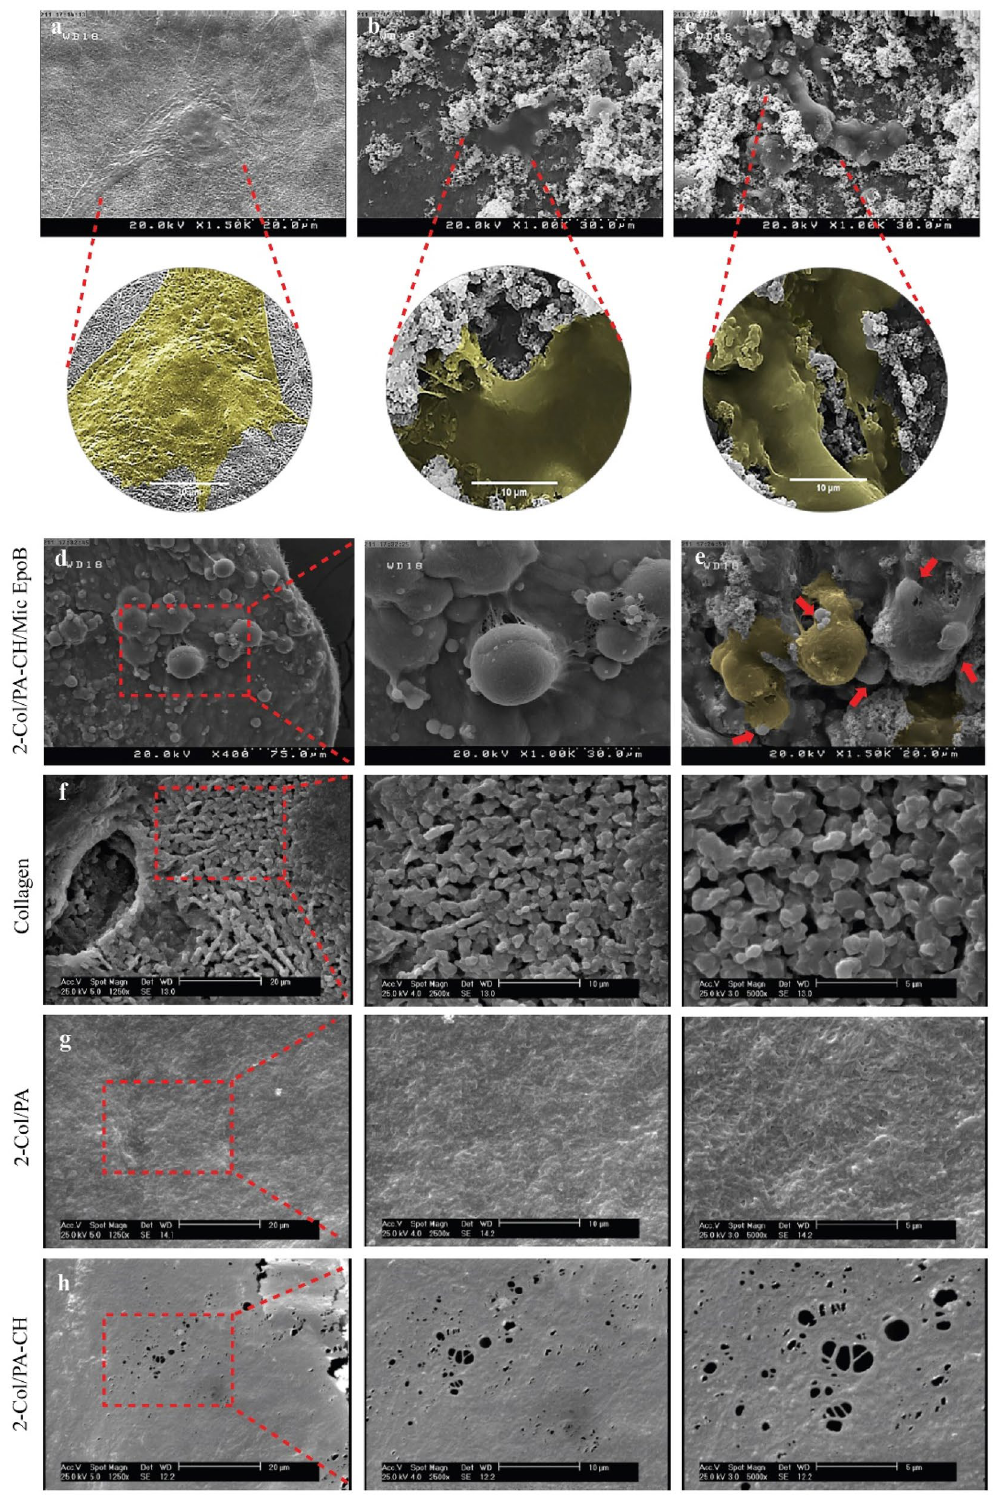
Figure 6. Cell attachment and surface morphology of different collagen hydrogel groups. Scanning electron micrographs of hEnSCs attachment on ( a ) collagen, ( b ) 2-Col/PA-CH, and ( c ) 2-Col/PA-CH/Mic EpoB hydrogels 48 h after cell seeding. Micrographs show hydrogel with cells at × 1000 and × 3000 magnifications (pseudo-colored). Scanning electron micrographs of different collagen hydrogel groups ( d – h ) indicates their surface morphology and interconnected porosity: 2-Col/PA-CH/Mic EpoB ( d , e ), collagen ( f ), 2-Col/PA ( g ), and 2-Col/PA-CH ( h ). EpoB microspheres were detected in the 2-Col/PA-CH/Mic EpoB hydrogel ( d , e ). Moreover, the cell attachment (highlighted in yellow) and EpoB microspheres (pointed with red arrows) are displayed in 2-Col/PA-CH/Mic EpoB hydrogel in Figure e